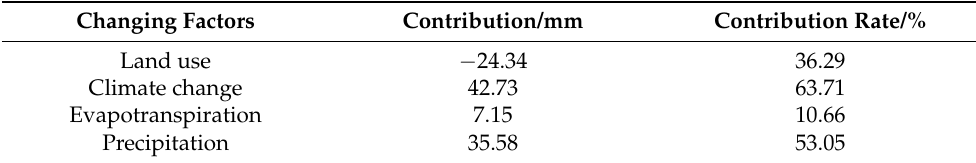
Table 12. Attribution Analysis of the Contribution Rate